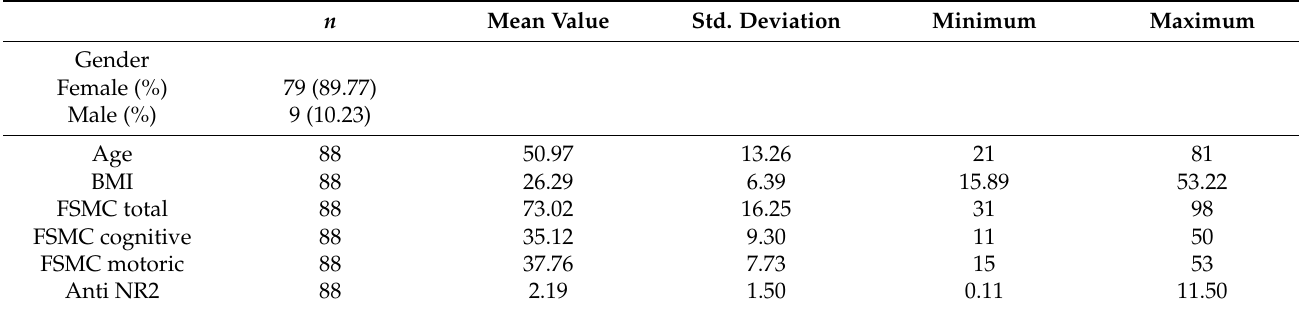
Table 1. Demographic characteristics of the patients.